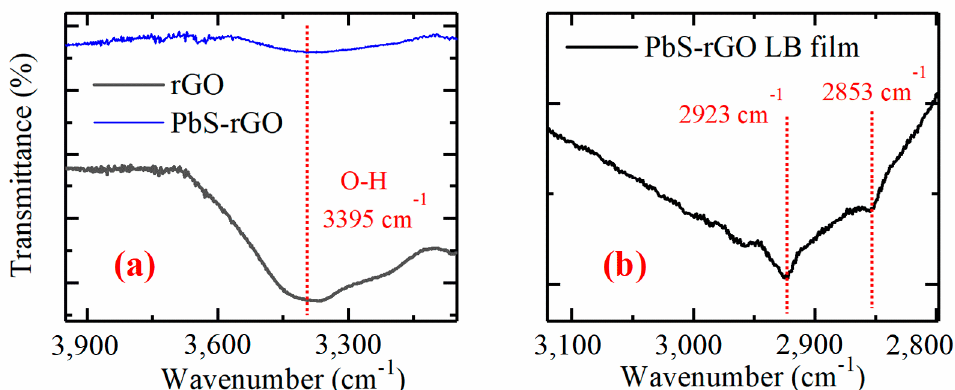
Figure 5. FTIR spectra of rGO–PbS hybrid indicating the O-H mode typical for rGO ( a ). FTIR spectra of rGO–PbS LB film indicating the traces of oleic acid on QD surface ( b ).